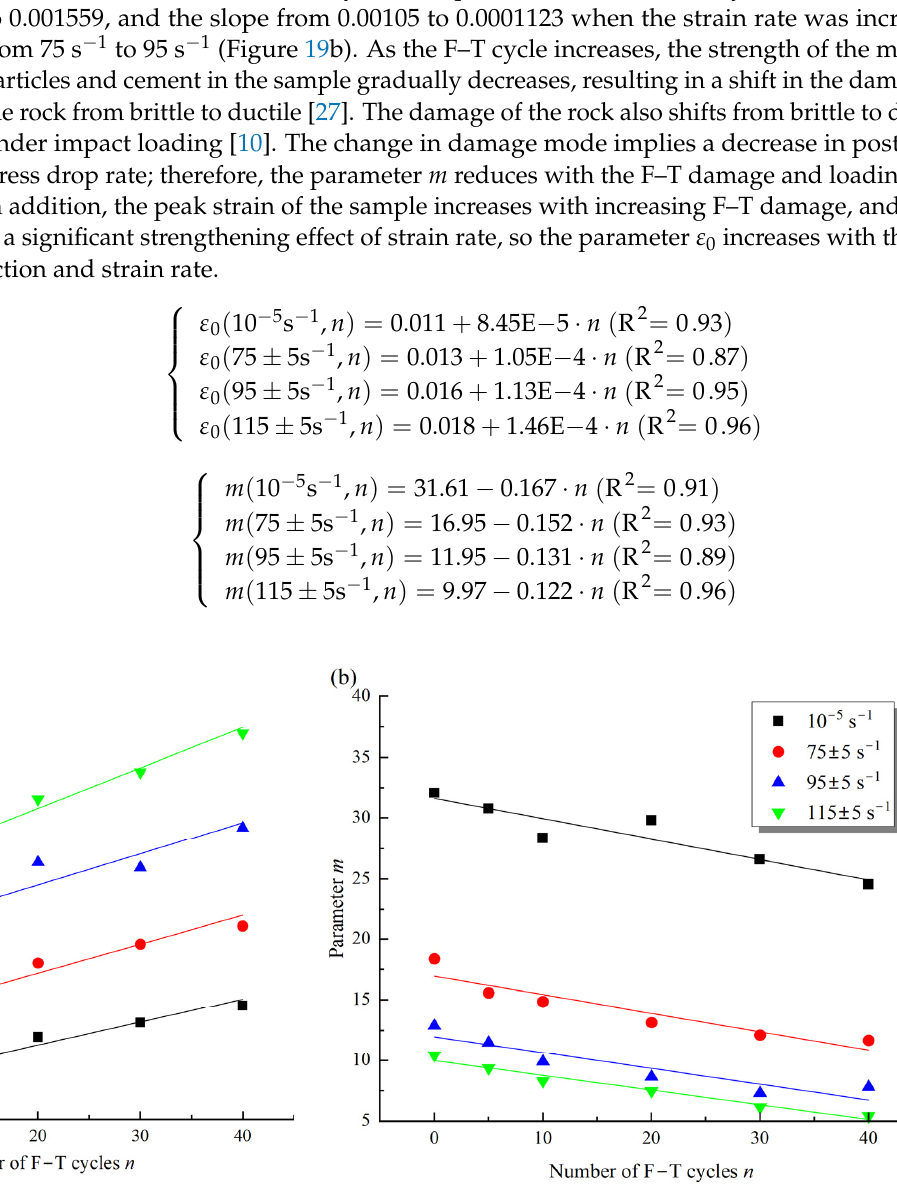
Figure 18. Analysis of parameter sensitivity in damage evolution model. ( a ) D n ; ( b ) 0